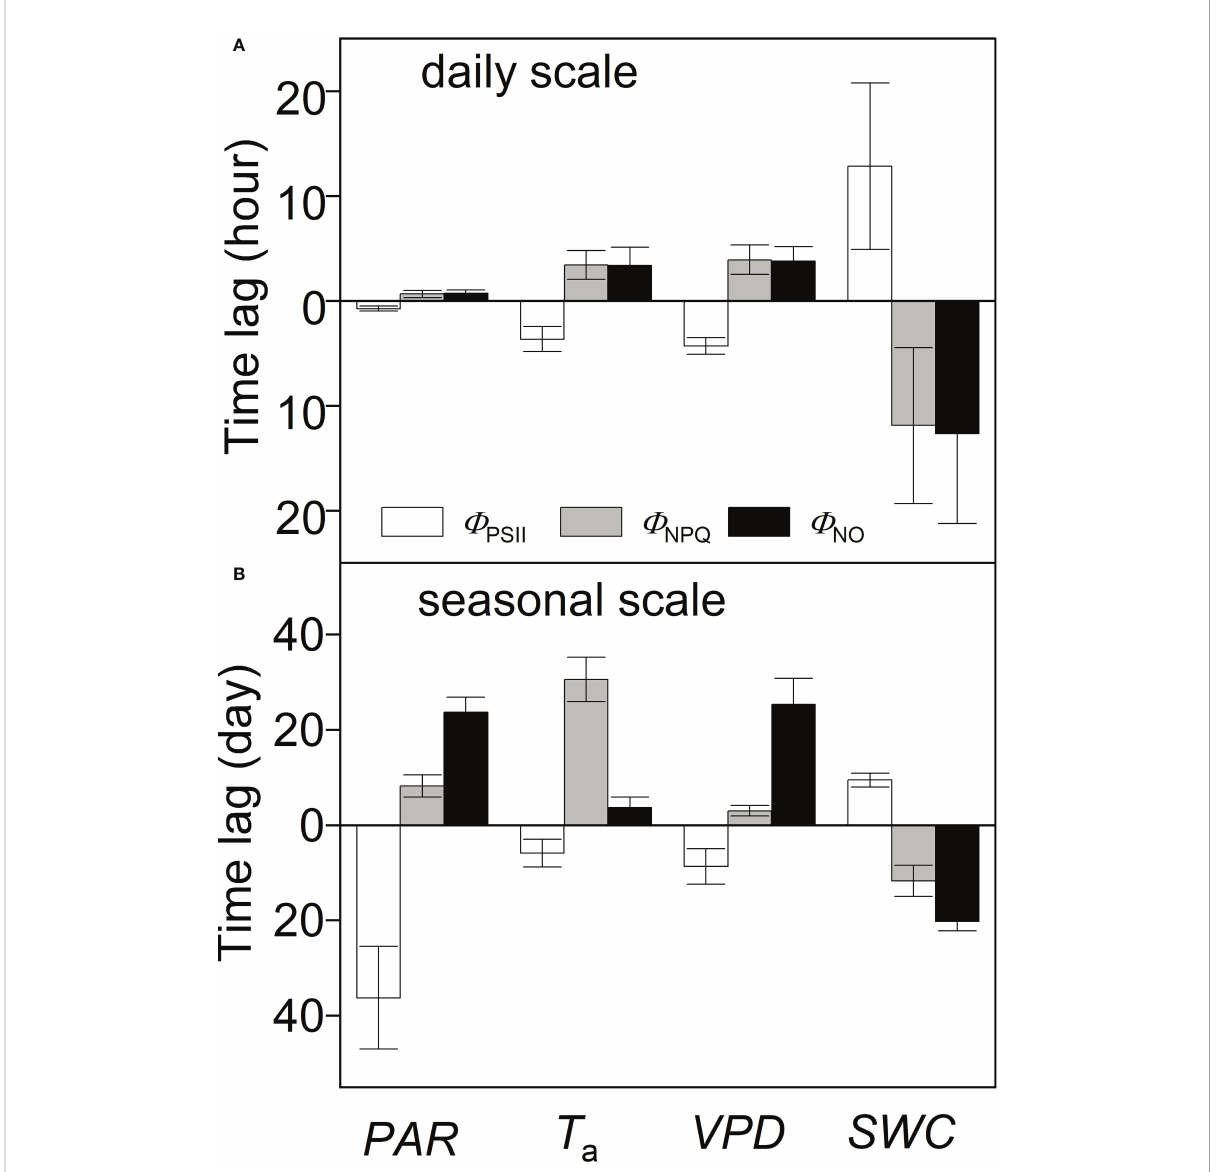
FIGURE 8 Time lags between PSII-energy partitioning measures and environmental factors at (A) daily and (B) seasonal timescales; F PSII = photochemical ef fi ciency; F NPQ = regulatory thermal dissipation; F NO = non-regulatory thermal dissipation; PAR = photosynthetically active radiation; T a = air temperature; VPD = vapor pressure de fi cit; and SWC = soil water content at a 0.3-m depth. Columns above the central line (at time lag = zero) indicate positive correlation, whereas columns below the line indicate negative correlation. Data represent mean ± standard deviation (error bars).